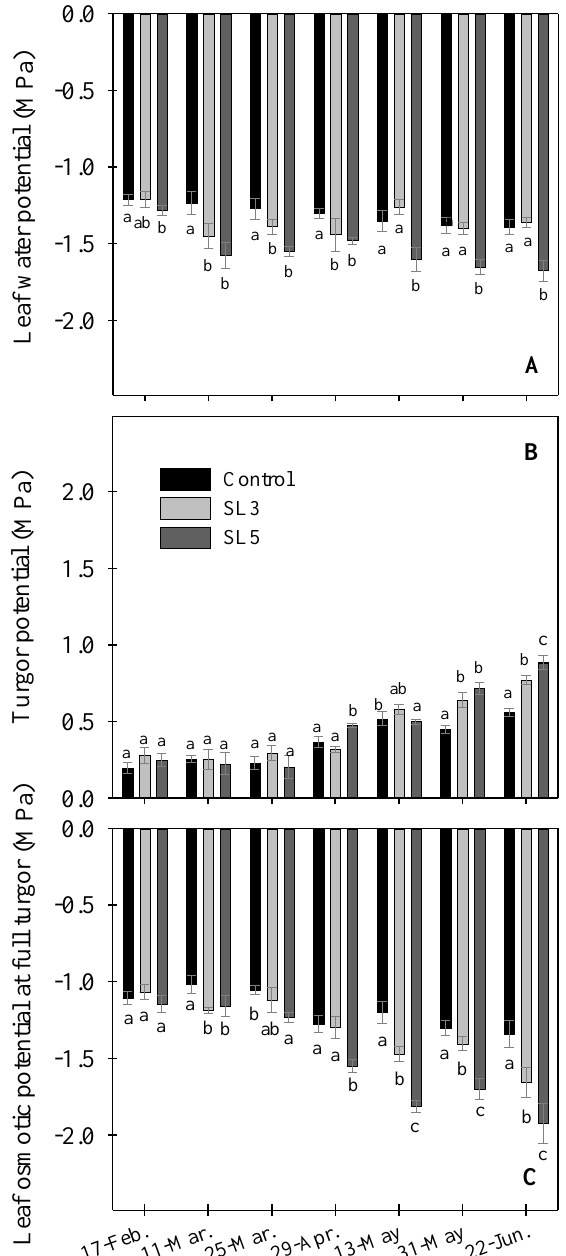
Figure 4. Water relations in Hebe plants (measured at midday): leaf water potential ( A ), leaf turgor potential ( B ), and leaf osmotic potential at full turgor ( C ). Control (1.8 dS m − 1 ), SL3 (3.3 dS m − 1 ), and SL5 (4.9 dS m − 1 ). Data are the mean of six calculations ± standard error. For each measurement date, different letters indicate significant differences between treatments according to the LSD test at p ≤ 0.05.